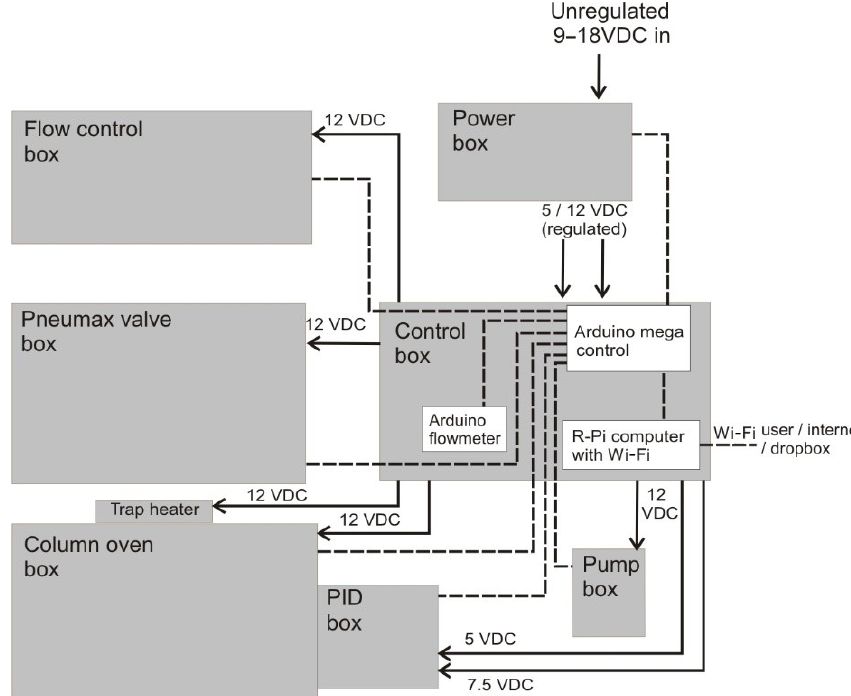
Figure 4. Schematic of Arduino Mega